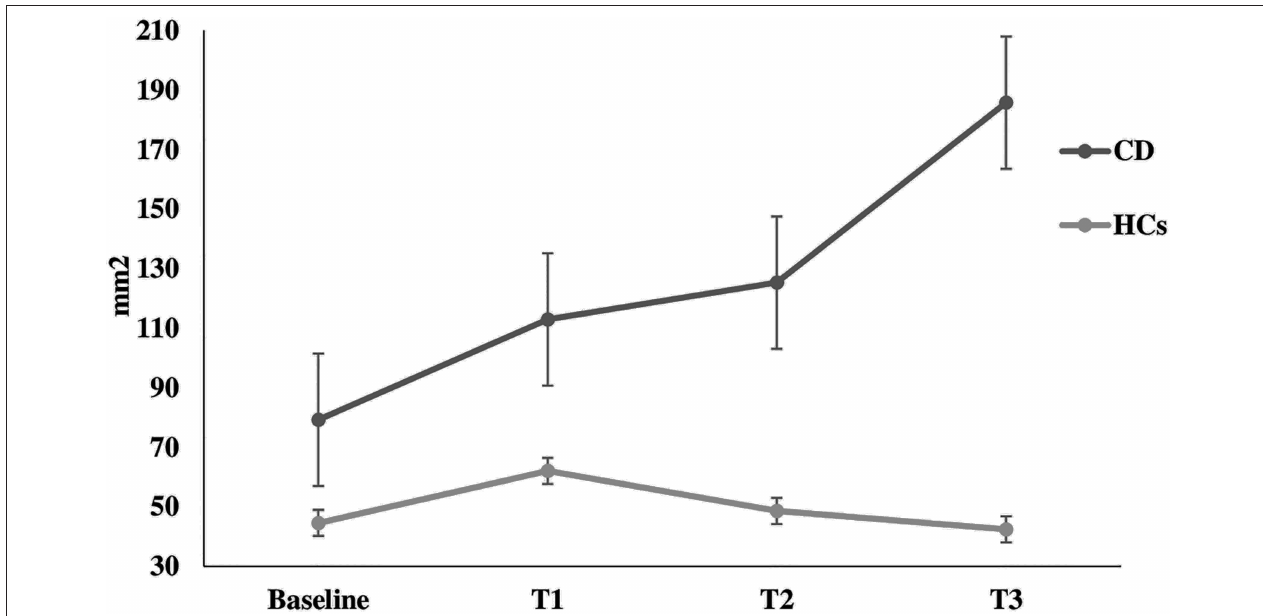
FIGURE 3 | Sway area. Sway area at rest (baseline) and during the execution of all Stroop test trials (T1, T2, T3) in healthy controls and in patients with cervical dystonia. HCs healthy controls; CD cervical dystonia; mm 2 square